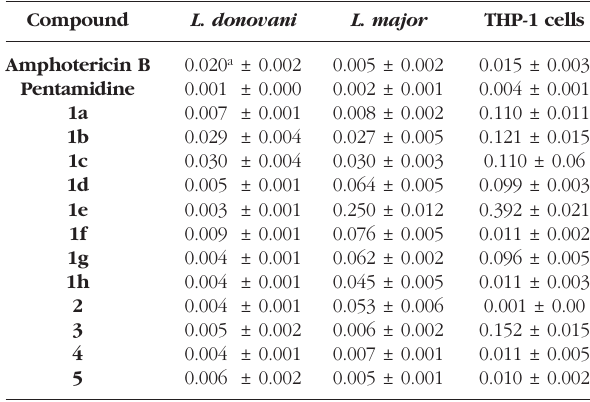
Table I. – IC50 (µM) of reference molecules and of non-quinonic compounds 1-5 against Leishmania donovani (MHOM/ET67/L82:LV9), L. major (MHOM/PT/92/CRE26) and human myelomonocytic cell line, THP-1 cells.